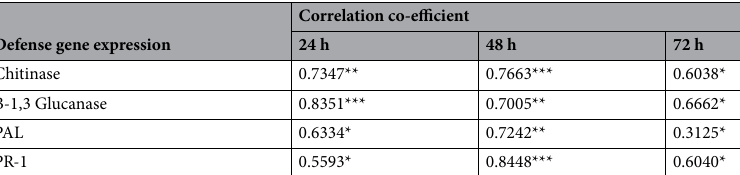
Table 4. Pearson correlation coefficients for A. alternata disease suppression in tomato plant and expression of defense related genes. Means labeled with ***showed significant positive correlation at p ≤ 0.001, with ** at p ≤ 0.01, and with * at p ≤